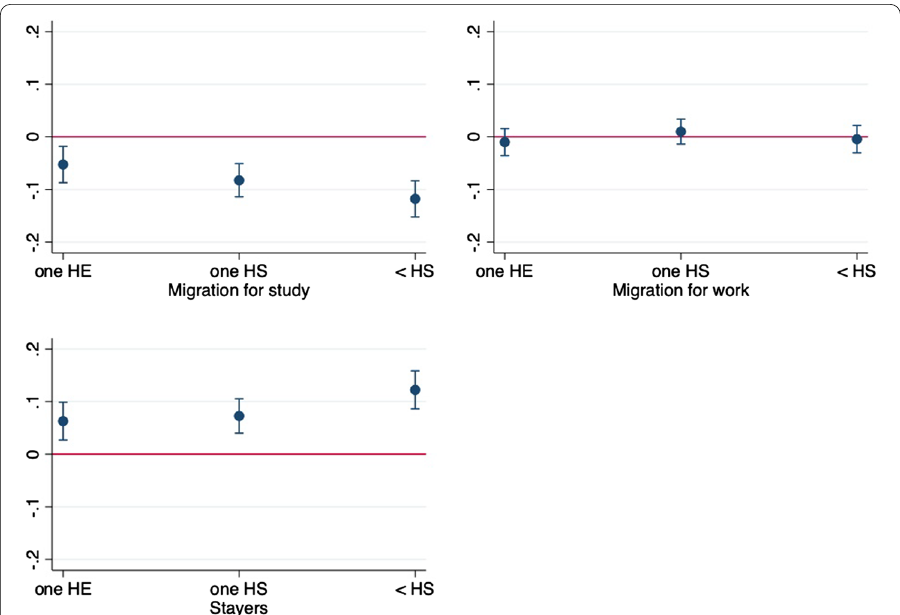
Fig. 3 Marginal changes in predicted migration behaviour as a function of parental education. Bars denote 95% confidence intervals; both HE parent with a higher education degree; one HS with less than a high school degree. Controls included in the